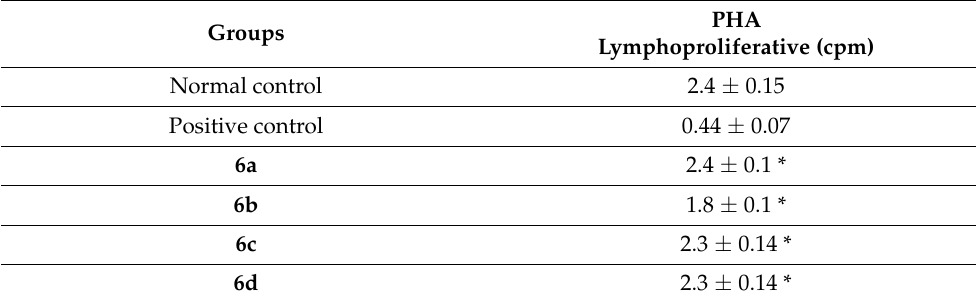
Table 8. Lymphoproliferative response to phytohemagglutinin mitogen (cpm) in control and EAC bearing mice treated with indoloquinoline derivatives.